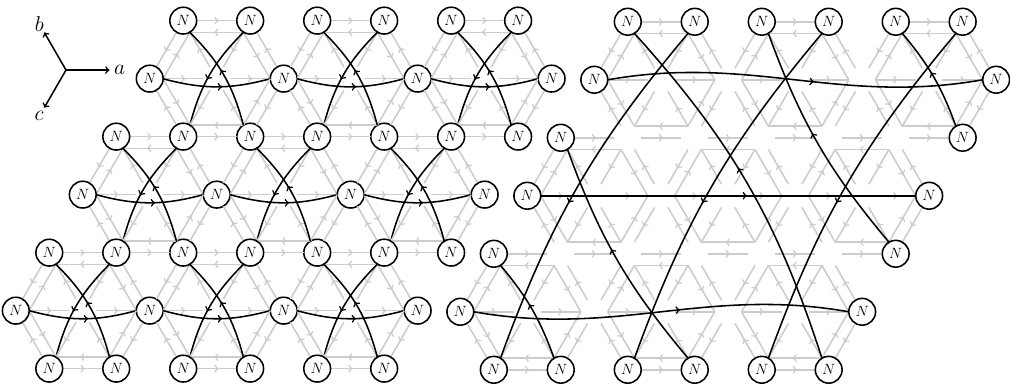
Figure 5 . After integrating out the quarks and mesons which have vectorlike masses of O ( λ Λ 3 N ) , the remaining light degrees of freedom are shown in the moose diagrams above. Left: at the intermediate scales Λ N (cid:28) µ < λ Λ 3 N , each SU( N ) gauge group in the bulk of the lattice is connected by bifundamental mesons to the SU( N ) nodes found on the far sides of the two neighboring unit cells. Rather than reconstructing a discretized 2d space, the SU( N ) sites of the µ (cid:28) Λ 3 N moose diagram are organized into several disjoint lines, oriented along the ϕ = 0 ◦ , 120 ◦ , and 240 ◦ directions, labelled a , b , c respectively. Right: in the far infrared of the theory, µ (cid:28) Λ N , the strongly coupled SU( N ) product gauge theory is replaced by its Seiberg dual. The degrees of freedom include “baryon” operators, ( M N ) , and extended “meson” operators, shown here as Wilson lines stretching between a opposing boundaries of the finite